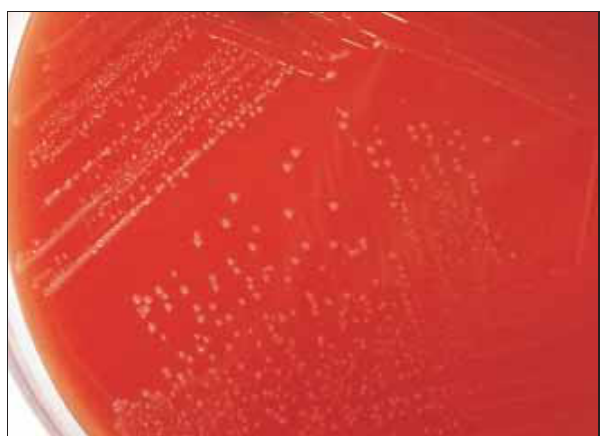
Figure-5a: Photograph showing non-hemolytic smooth colonies of on SBA plate. P. multocida